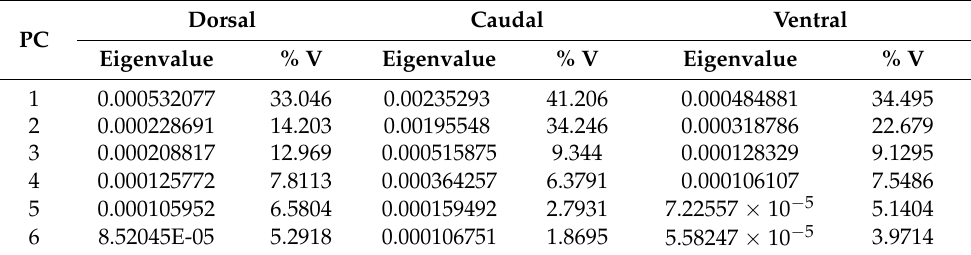
Table 1. Principal Components (PC) Eigenvalues describing the highest variation (V) for dorsal, caudal, and ventral view, as a result of principal component analysis, and variation values it explains. Dorsal Caudal Ventral PC Eigenvalue % V Eigenvalue % V Eigenvalue % V 1 0.000532077 33.046 0.00235293 41.206 0.000484881 34.495 2 0.000228691